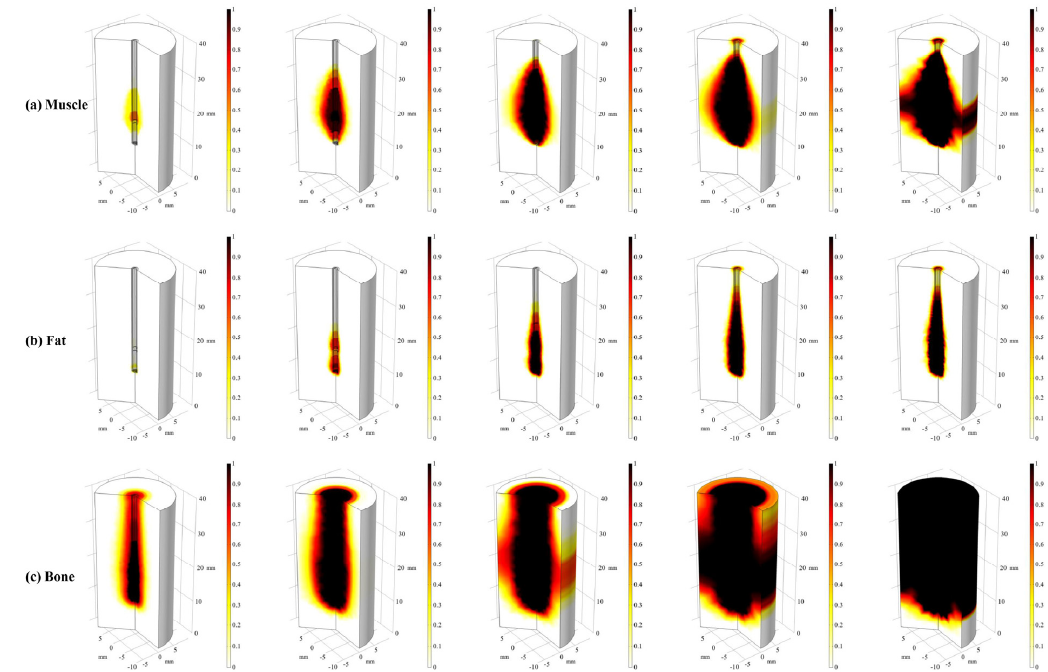
Figure 6. Damage fraction cloud map at 15 s, 30 s, 45 s, 60 s, 75 s. Damage fraction is calculated by temperature threshold. Its damage temperature T d is set to 50 ◦ C, and necrosis temperature T n is set to 80 ◦ C. Damage time is set to 15 s. ( a ) Damage fraction cloud map of muscle; ( b ) Damage fraction cloud map of fat; ( c ) Damage fraction cloud map of bone.